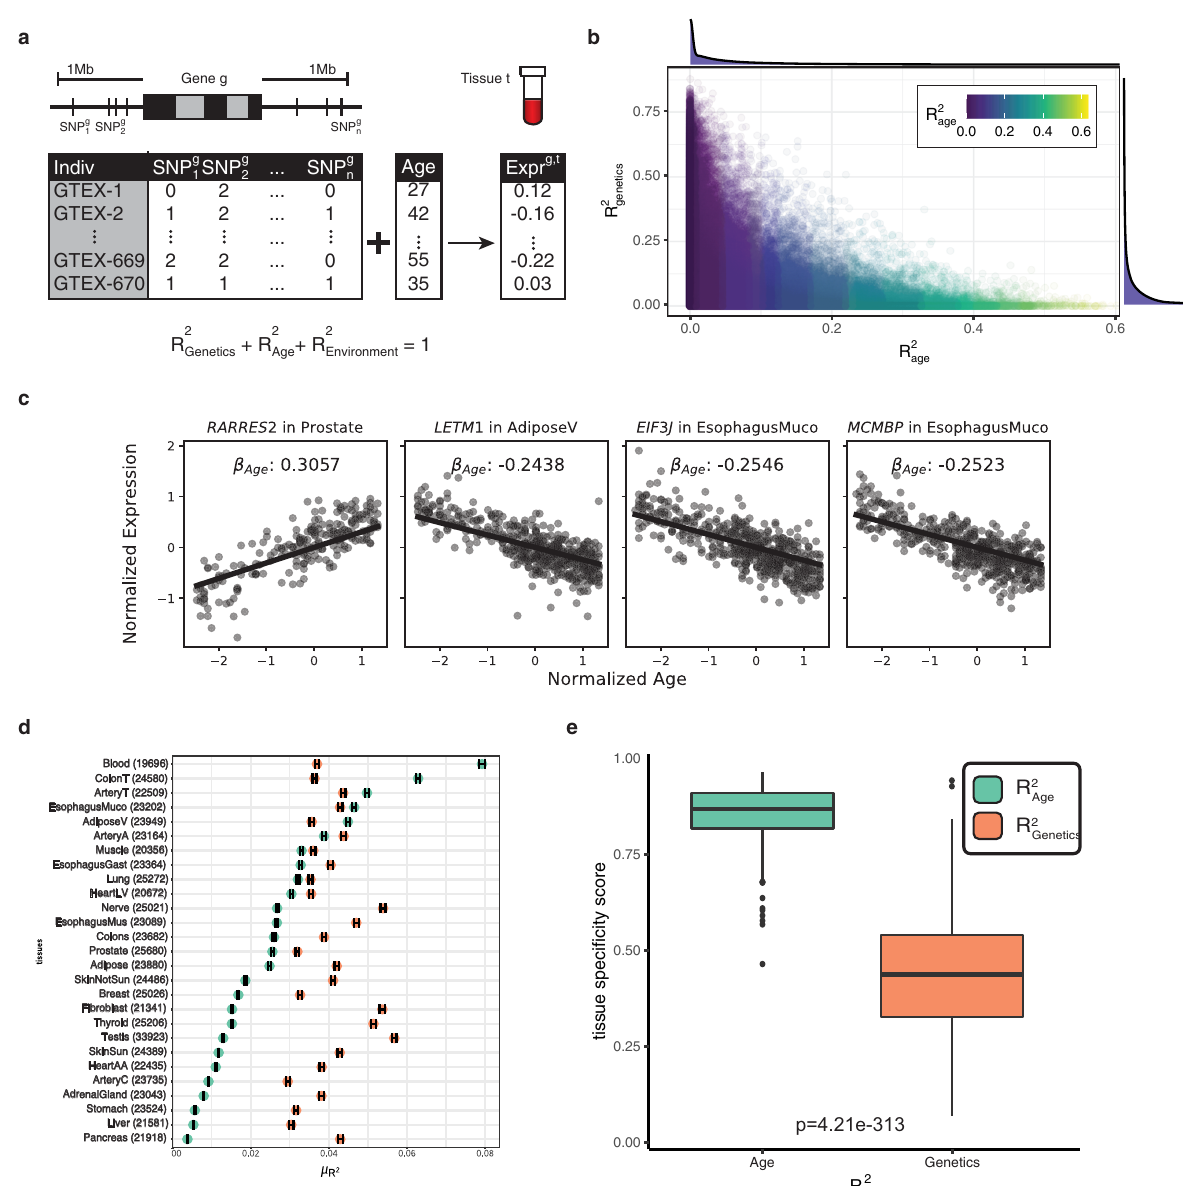
Fig. 3 | A joint predictive model of gene expression identi fi es tissue-speci fi c contributions of age and genetics to transcript levels. a A schematic of our multi-SNP gene expression association model incorporating sample age. Common SNPs around each gene g are used in combination with an individual's age to predict expression within tissue t . Using this trained model, variation in gene expression can be separated into three parts: the components explained by genetics ( R 2 genetics or h 2 ), by age ( R 2 age ) and by all other factors ( R 2 environment ). b Proportion of each gene's expression variance explained by age and genetics.